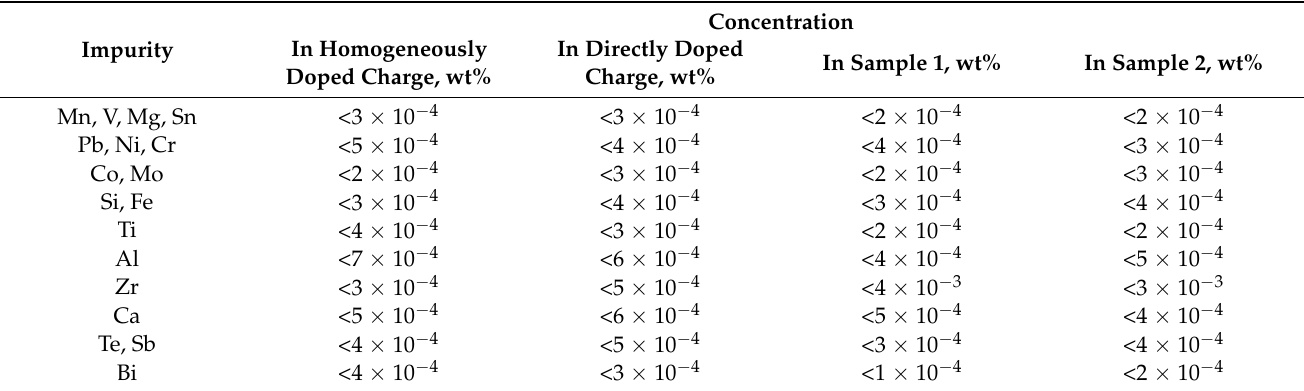
Table 2. Impurity composition of charge and samples 1 and 2